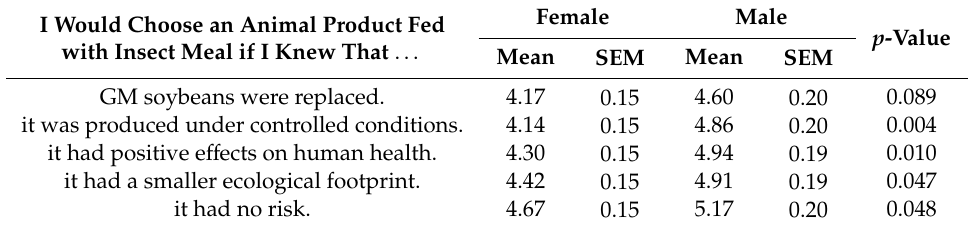
Table 5. Factors influencing the acceptance of products that originated from animals fed with insect meal, depending on the age of respondents (on a 1 to 7 scale).